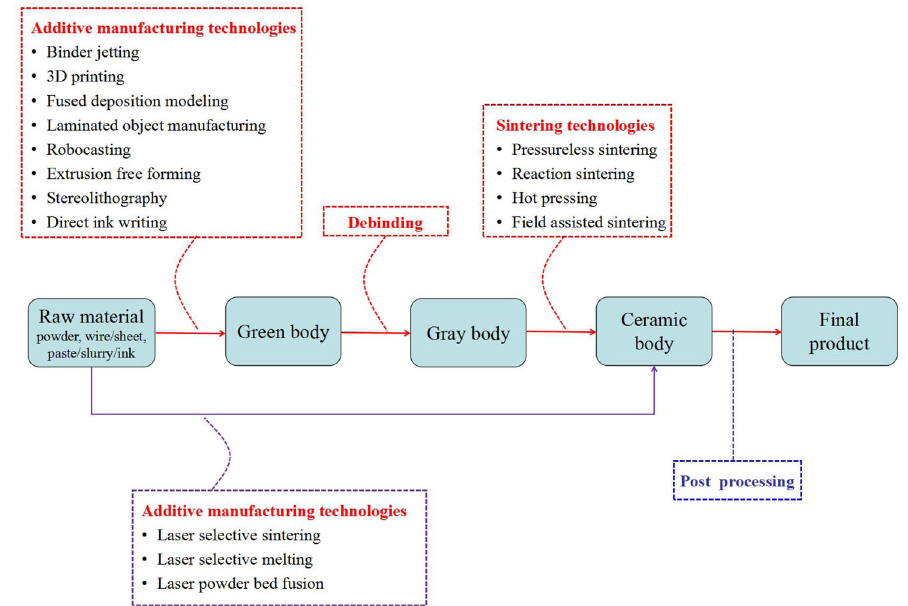
Fig. 7 Direct additive manufacturing of SiC